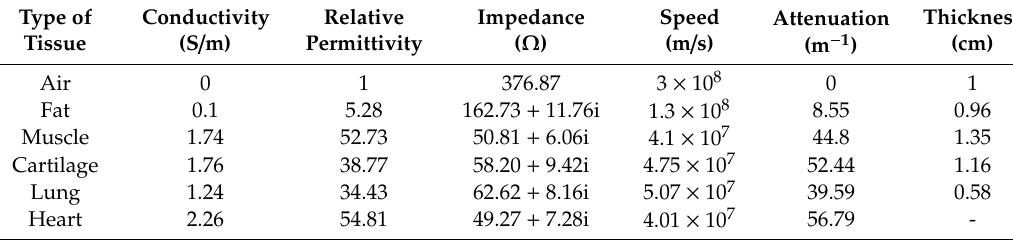
Table 2. EM properties of human-body tissue at 2.45 GHz.